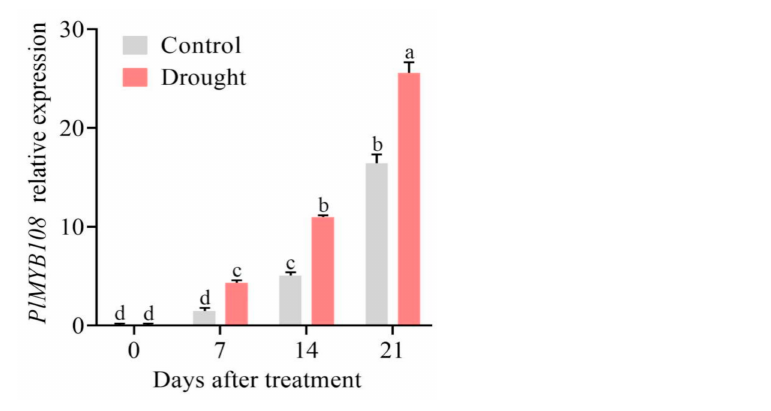
Figure 3. Relative expression levels of PlMYB108 in P. lactiflora under drought stress. The values represent the mean ± SD, and different letters indicate significant differences according to Duncan’s multiple range test ( p < 0.05).